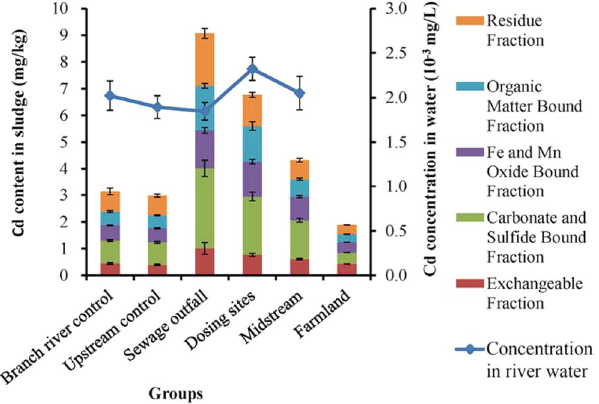
Figure 2. The mean Cd content of different phases in the sludge of different groups and the Cd concentration in water. The error bars represent standard deviation.